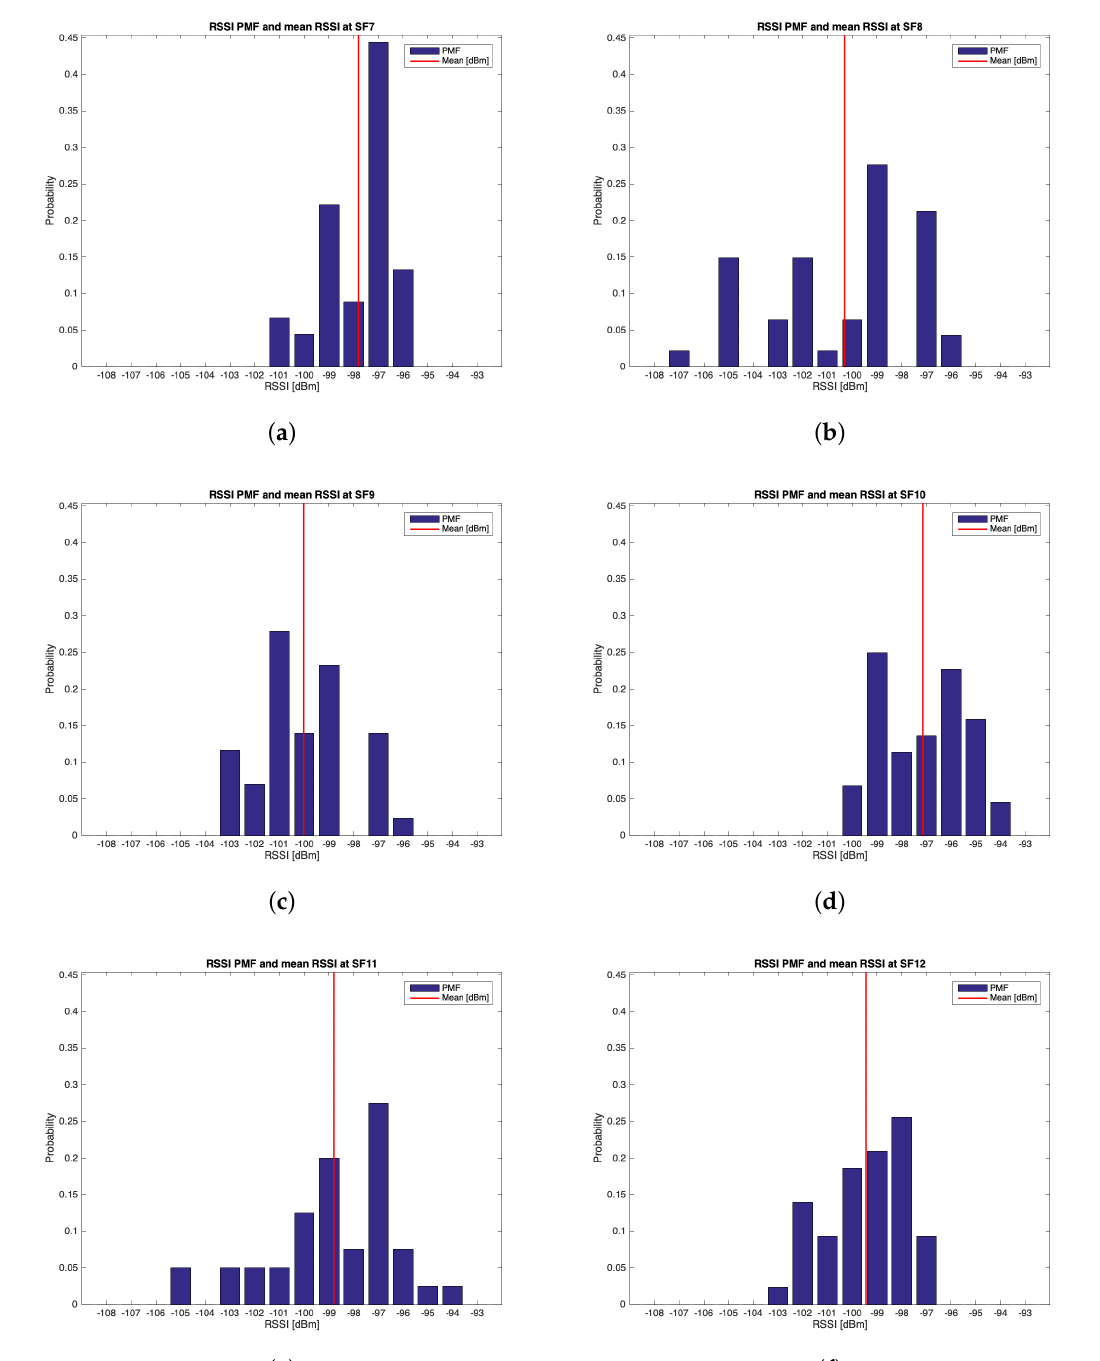
Figure 10. Group #1 RSSIs PMFs: ( a ) SF = 7; ( b ) SF = 8; ( c ) SF = 9; ( d ) SF = 10; ( e ) SF = 11; ( f ) SF =